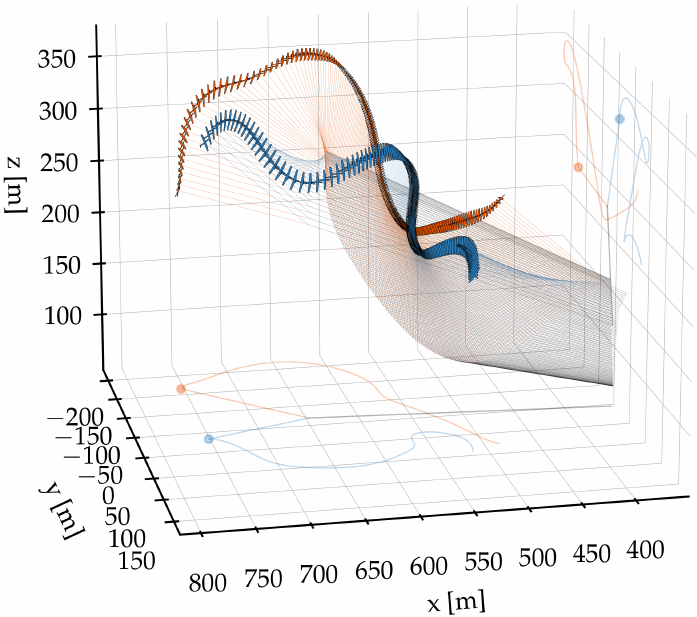
Figure 8. Optimal dual-aircraft flight trajectories for u ref = 18 m the aircraft are depicted at a scale 3.3:1. Aircraft k = 2 is plotted in blue, aircraft k = 3 in